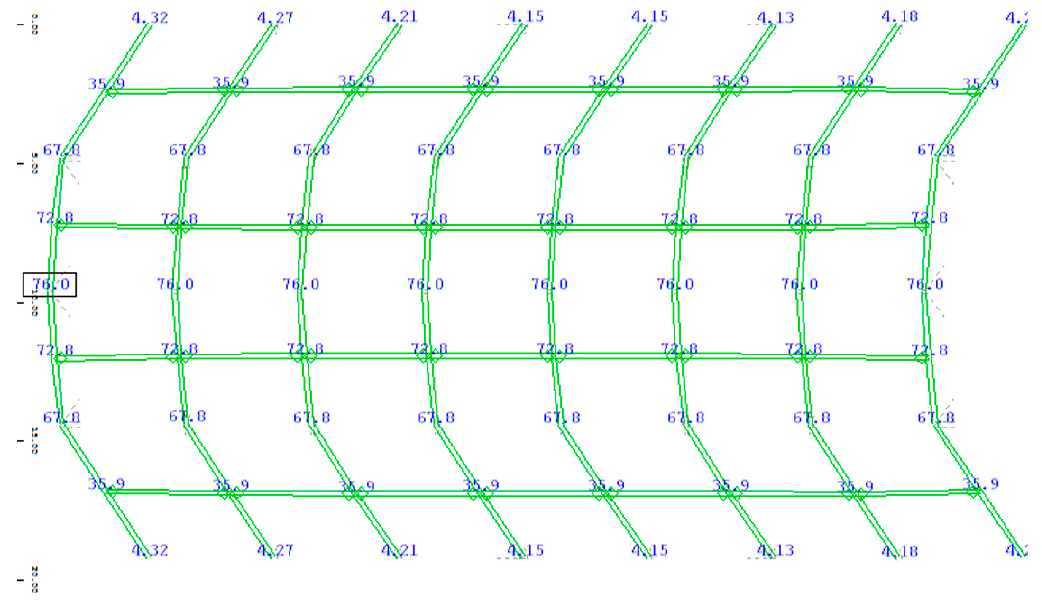
Figure 18. Maximum horizontal displacement on the roof parallel to the gutter of the Venlo-type greenhouse.